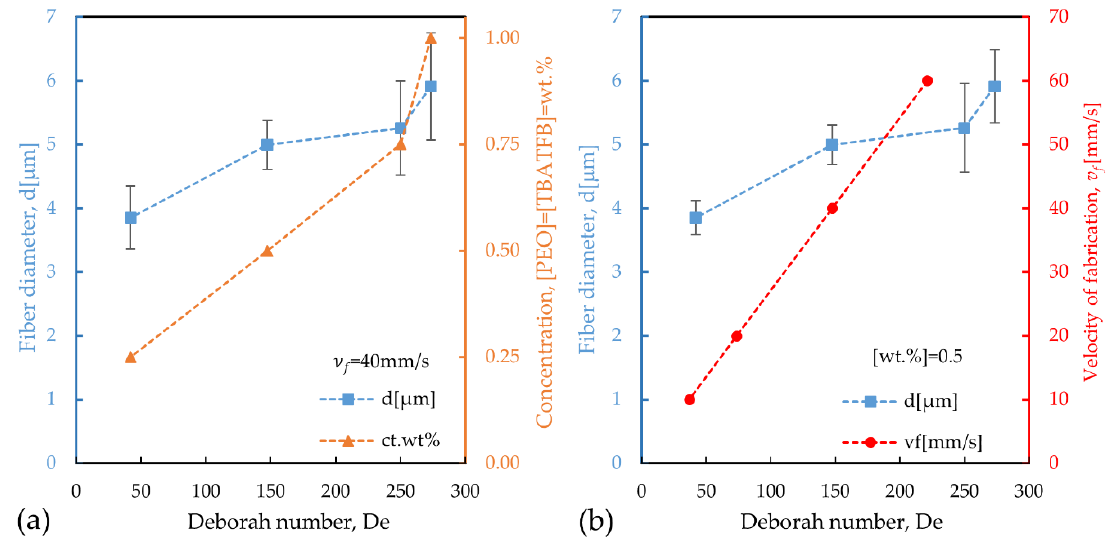
Figure 5. (a ) Effect of the concentration of PEO and TBATFB on the Deborah number and the diameter of the fibers when v f = 40 mm/s. ( b ) Effect of v f on the Deborah number and diameter of the fibers for of the fibers when v f = 40 mm / s. ( b ) E ff ect of v f on the Deborah number and diameter of the fibers for a a concentration of 0.50 wt% of PEO and TBATFB. concentration of 0.50 wt% of PEO and